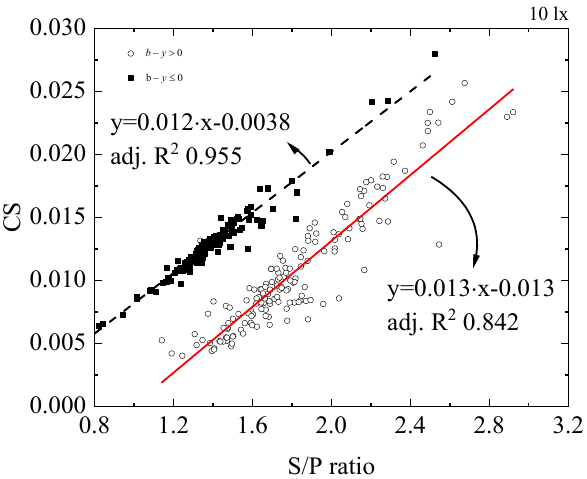
Figure 7. CS as a function of the S/P ratio at 10 lx.